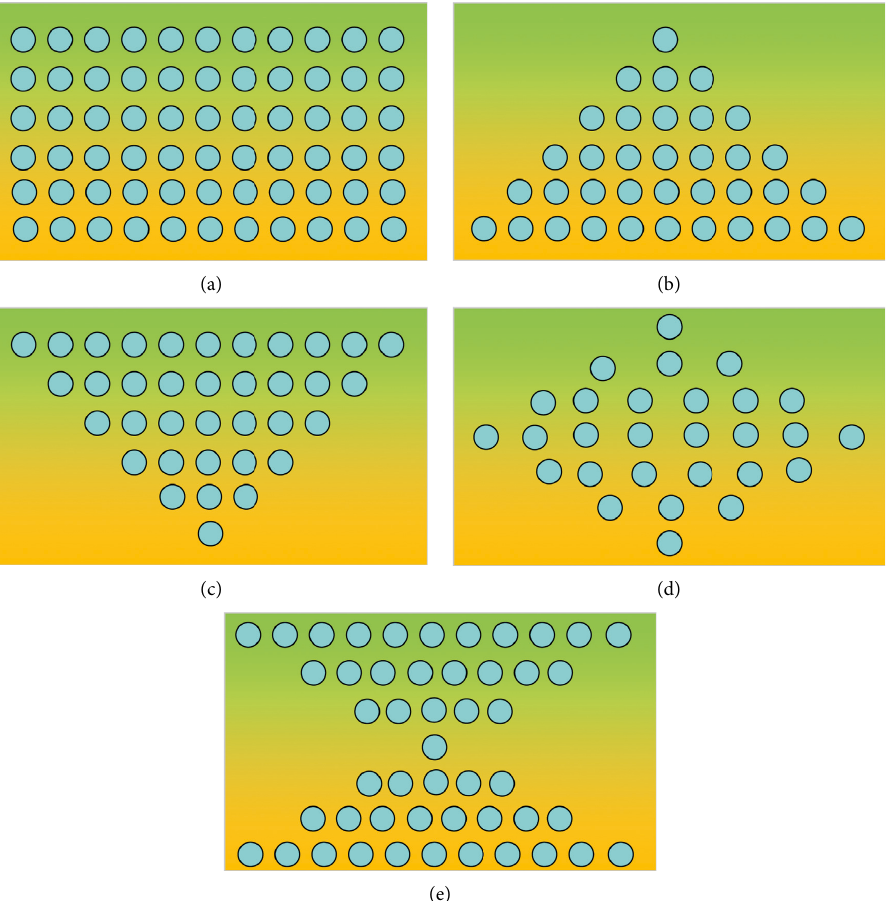
Figure 2: Distribution patterns of CNTs in FG-CNTRC plates. (a) UD-CNTRC. (b) FG- Λ CNTRC. (c) FG-V CNTRC. (d) FG-O CNTRC. (e) FG-X CNTRC.